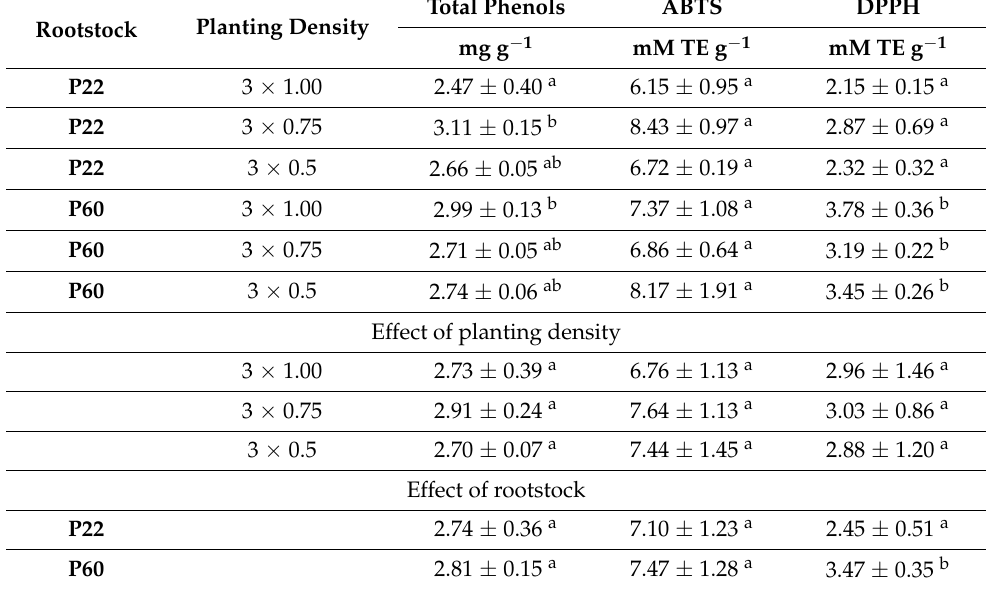
Table 1. The effect of distances and rootstock on total phenols and DPPH and ABTS radical scavenging activity in apple fruits. The mean value (n = 3 × 3 = 9) ± standard deviation is presented. The data were processed using a two-way analysis of variance (ANOVA), the Tukey (HSD) test at the confidence level p = 0.05. The different letters in blocks indicate significant differences.